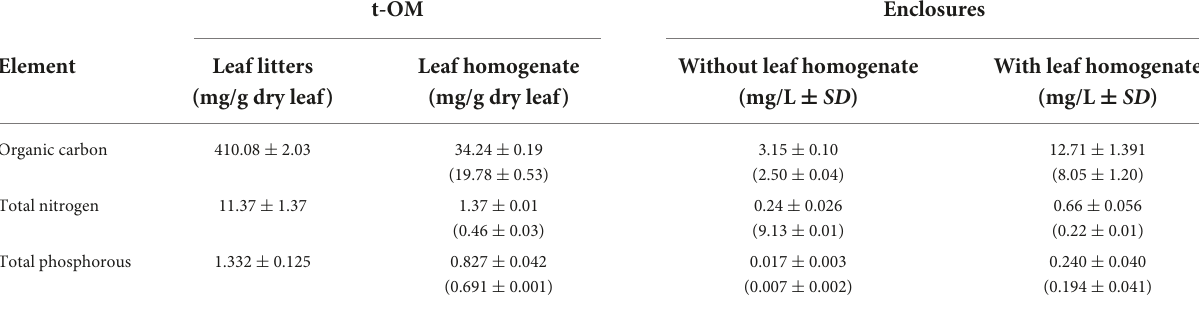
TABLE 1 Mean and standard deviation ( SD ) of total organic carbon, total nitrogen, and total phosphorus contents of leaf litter (fallen leaves) and leaf homogenate used in the experiment, and concentrations of these elements in enclosures at the beginning of